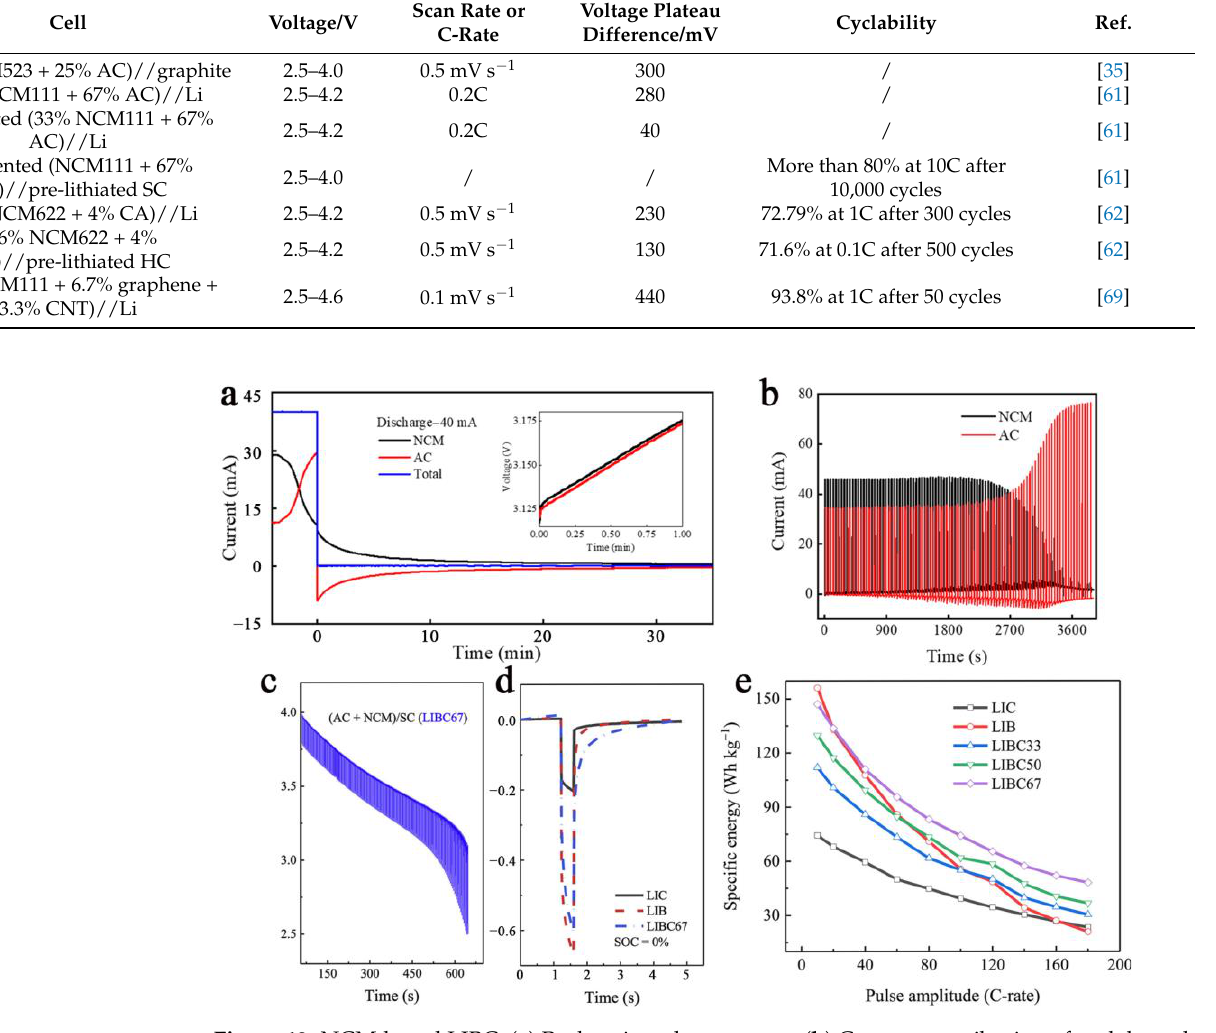
Figure 12. NCM-based LIBC: ( a ) Recharging phenomenon; ( b ) Current contribution of each branch for the pulsed discharge [39]. ( c ) Pulsed discharge voltage profile; ( d ) Voltage drop profile of a single pulse at SOC of 0%; ( e ) Specific energy for the increasing pulse amplitude [61].